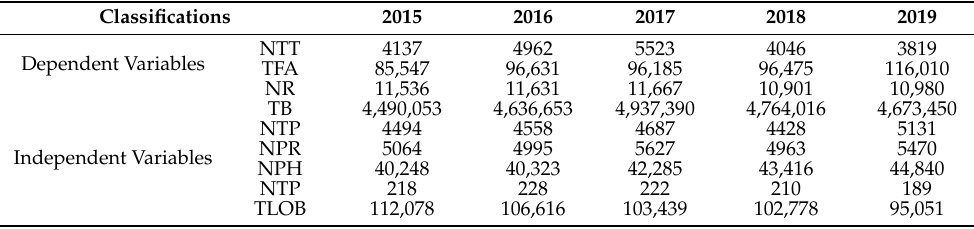
Table 3. Results of the basic statistical analysis by year.